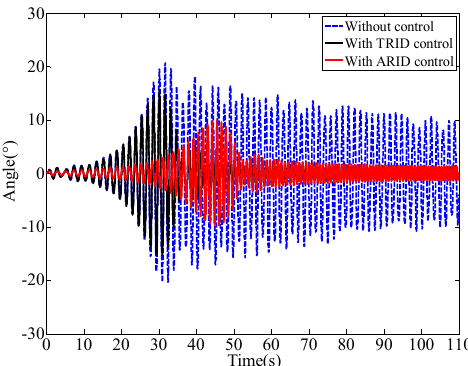
Figure 8. Numerical results of the swing angle of the structure with the TRID or ARID system.